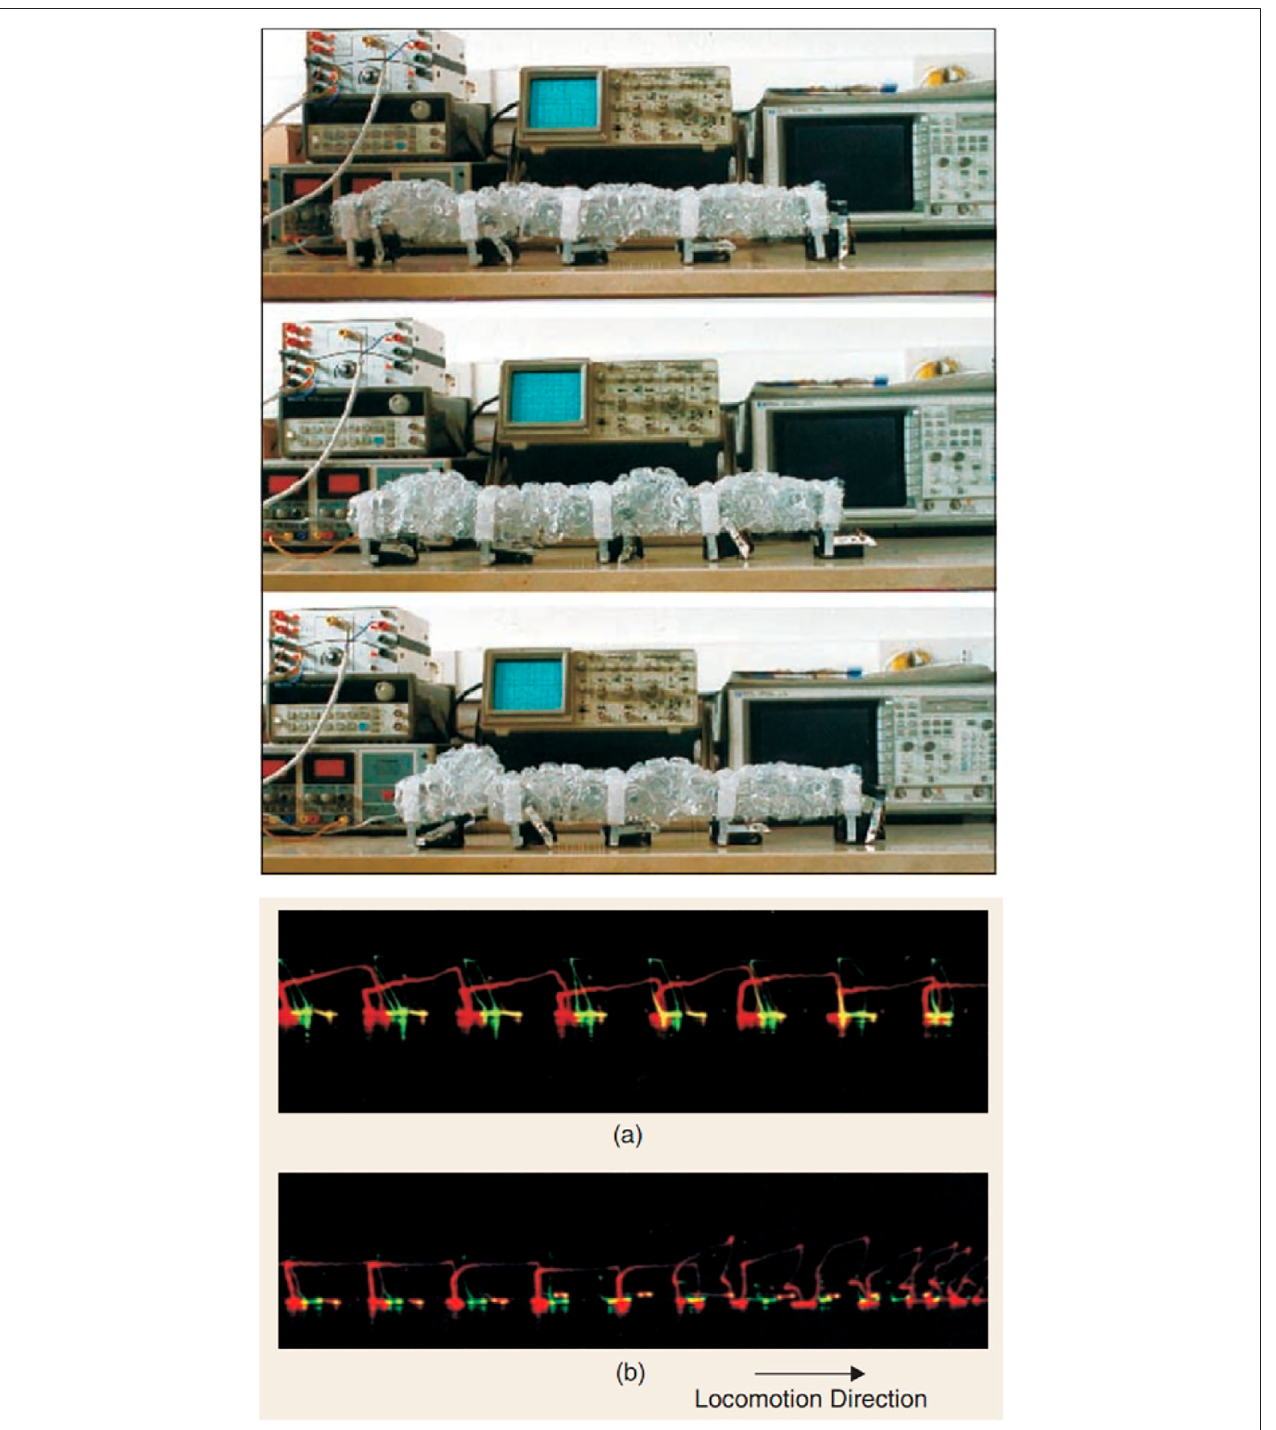
FIGURE4|(A) Aseries offramesillustrating motionoftheworm-likerobot. (B) Regularlocomotion leg cycles and (C) irregular leg cycles due toCNN ringdamage in thehexapodrobot. Theimage sequences wereobtainedby recording, inalong-exposure photo, thelightemitted byLEDs mounted onthe robot foots. The red trace is associated to the front leg trajectory, the green one to the middle leg, and the yellow to the hind leg.